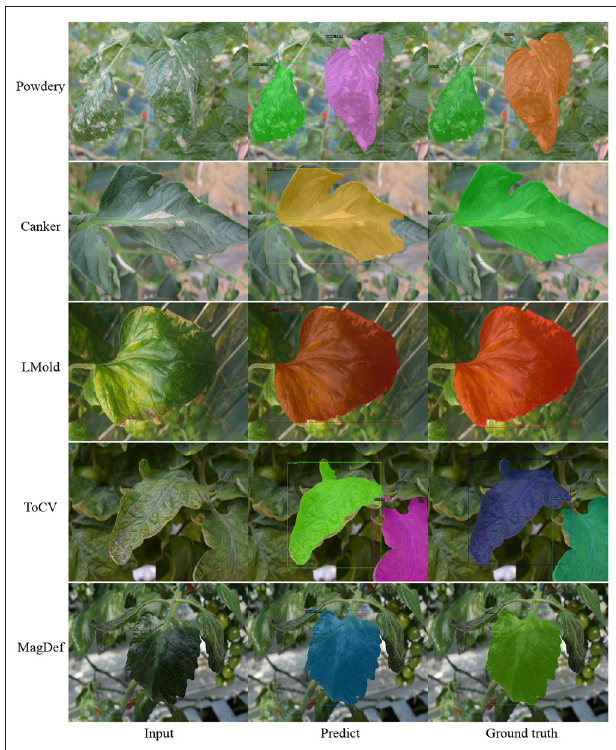
FIGURE 9 | Result samples of instance segmentation in different diseases with our SCIT model as data augmentation model and λ sty = 2. The predicted results are decent compared to the ground truth. Zoom in to see the bounding